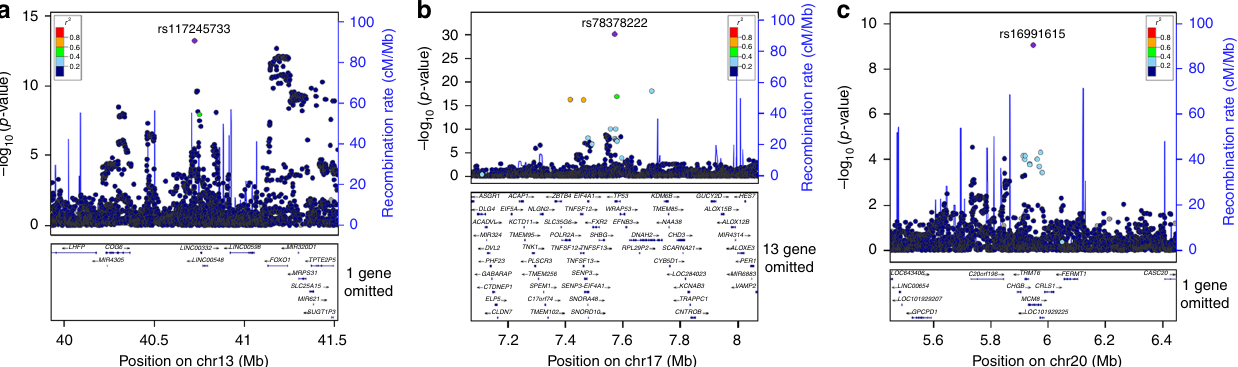
Fig. 2 Fine-mapping reveals three association signals with a single driver in 99% credible set. Association with UL is expressed as − log 10 ( P value) for the three signals on chromosomes: ( a ) 13q14.11, ( b ) 17p13.1, and ( c ) 20p12.3. The labeled SNP represents the most signi fi cant SNP for each locus. SNP association P -value is shown on the y axis, while SNP position (with gene annotation) appears on the x axis. Each SNP is colored according to the strength of LD with the lead SNP. Regional association plots were produced in LocusZoom